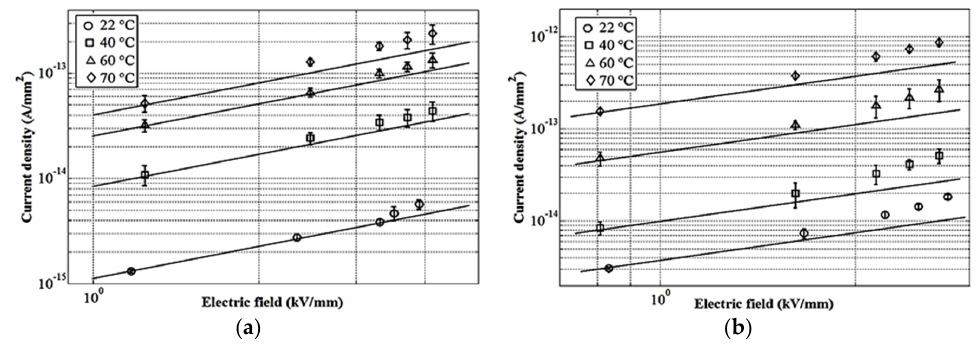
Figure 3. Field strength—current density characteristics obtained for materials A ( a ) and B ( b ) at different temperatures. The lines indicate the unit-slopes, the error bars show the standard deviations.